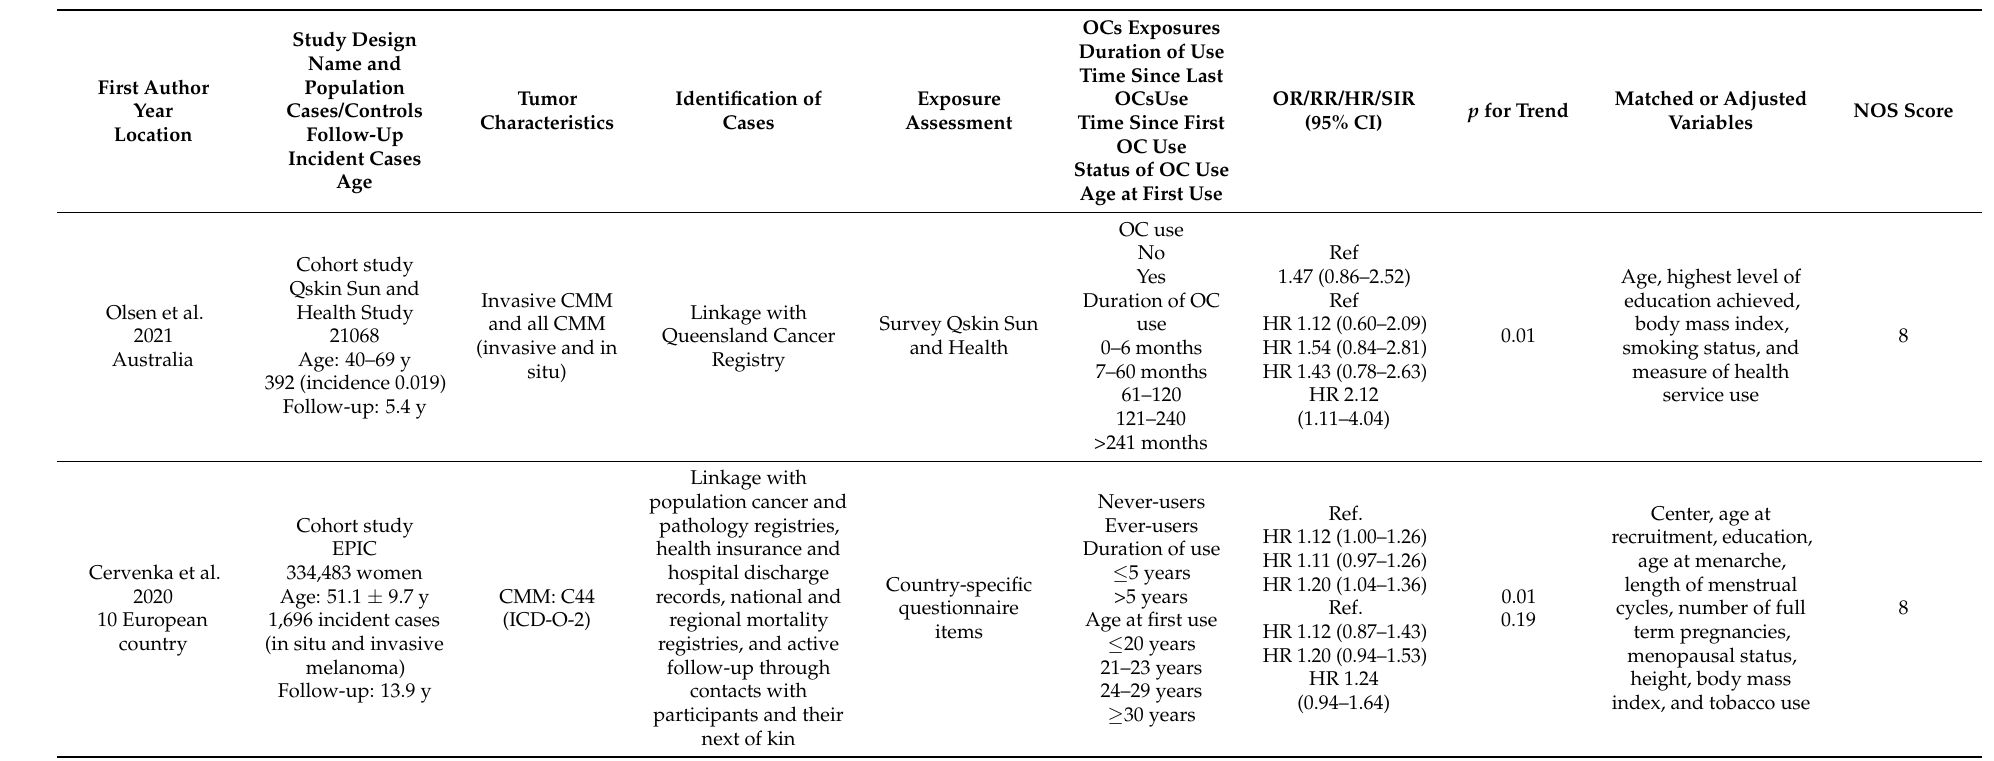
Table A1. Main characteristics of studies included in the systematic review and meta-analysis on oral contraceptive (OC) use and malignant melanoma